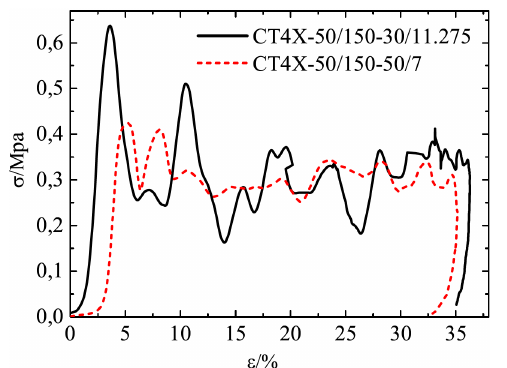
Figure 17: Influence of impact energy on cushioning energy absorp- tion of X-direction paper corrugation